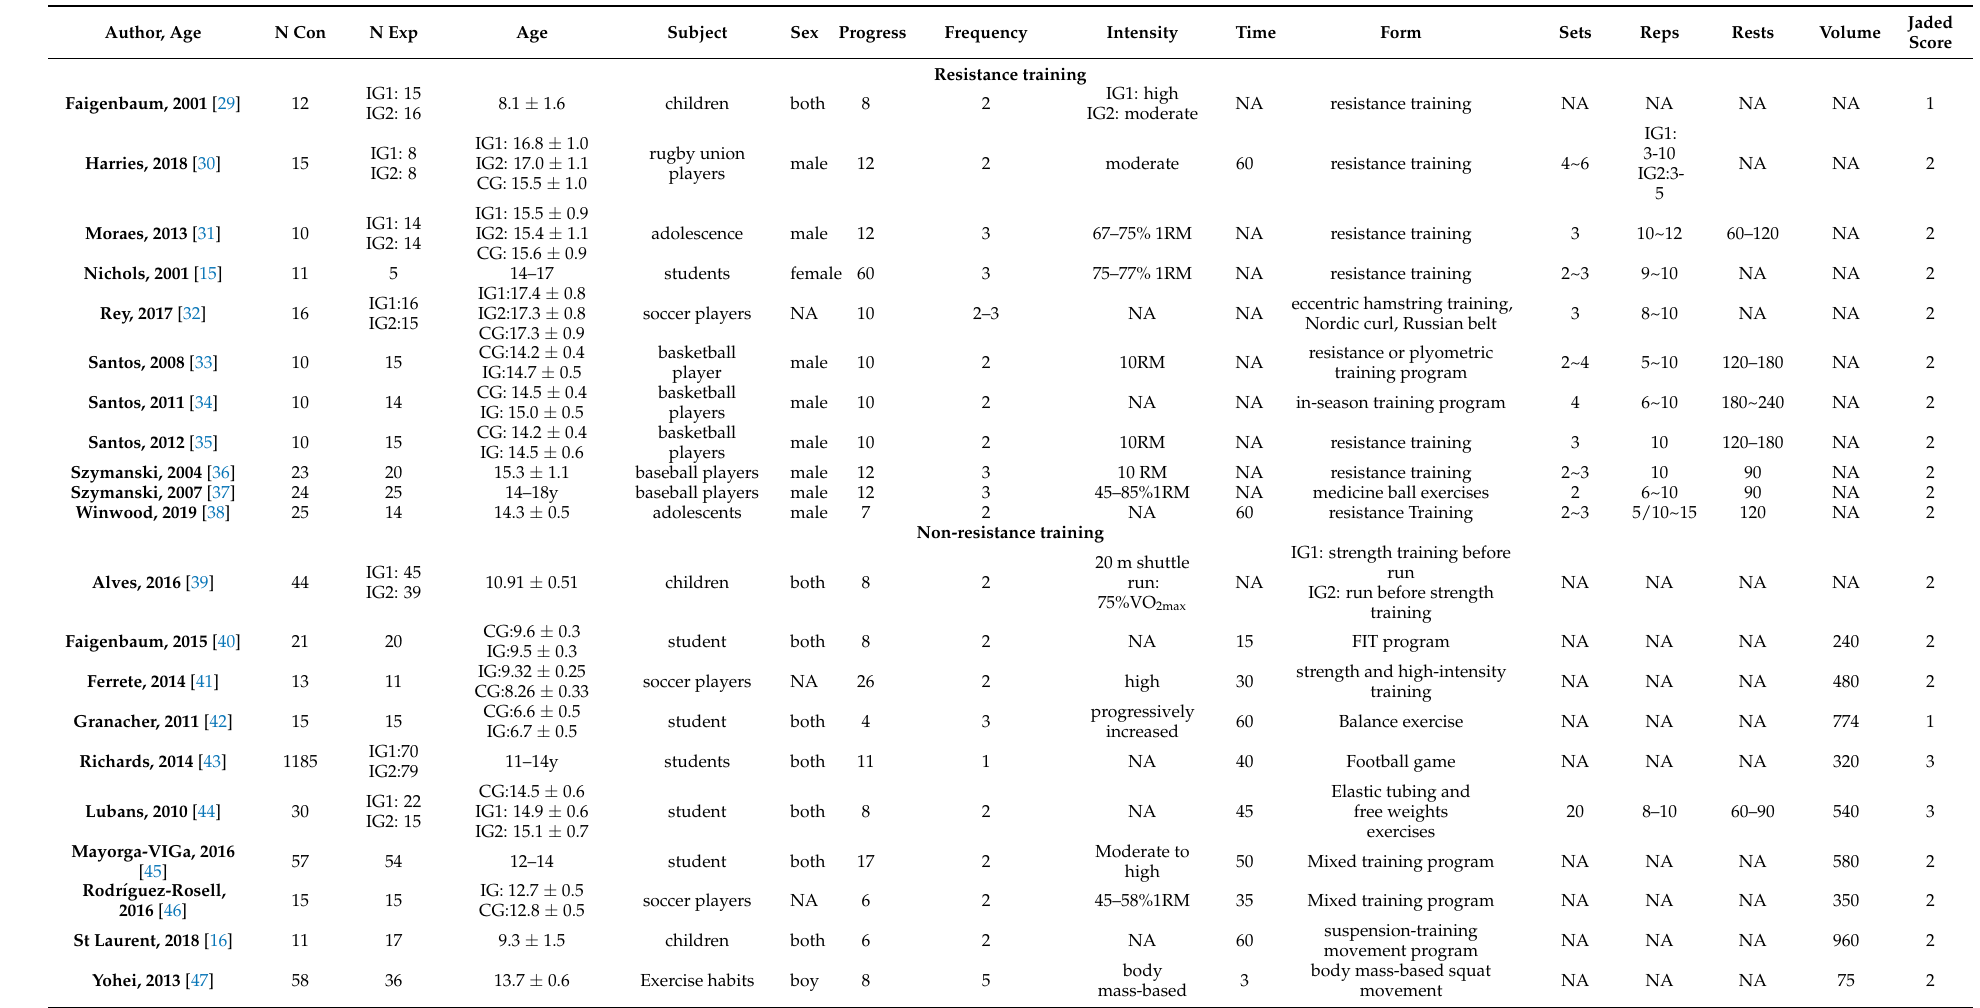
Table 1. Included studies examining the effects of physical activity in children and